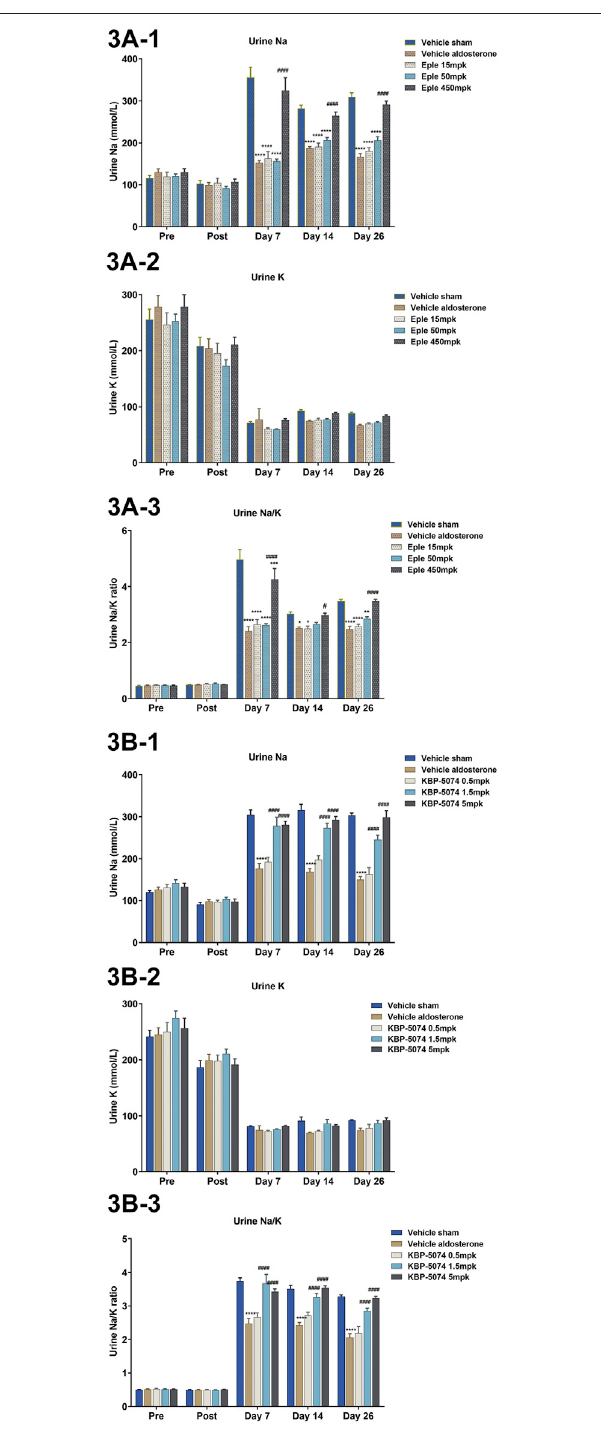
FIGURE 3 | Effects of eplerenone and KBP-5074 on urine Na + , K + , and Na + /K + ratio in (A) eplerenone and (B) KBP-5074. Values are expressed as mean ± SEM. n (cid:2) 11 – 13. * p < 0.05, ** p < 0.01, **** p < 0.0001 vs. Vehicle Sham group, # p < 0.05, #### p < 0.0001 vs. Vehicle Aldosterone group followed by two-way ANOVA Tukey ’ s multiple comparisons test. Eple, eplerenone; SEM, standard error of the mean.